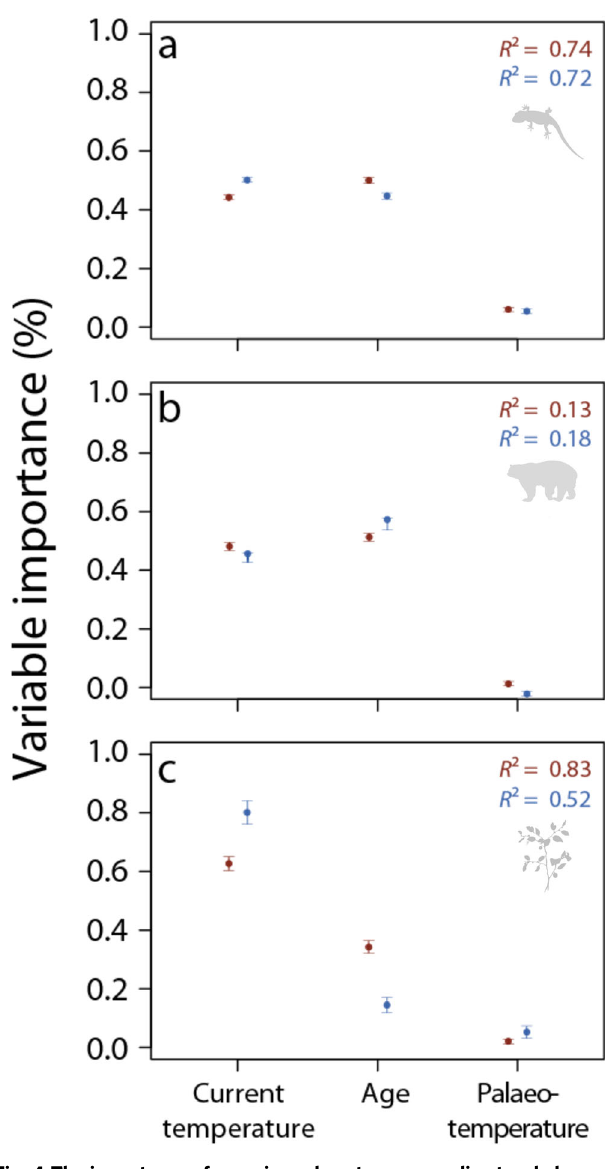
Fig. 4 The importance of experienced contemporary climate, clade evolutionary age and palaeoclimatic origin in predicting thermal limits. Variable importance in random forest models fi tting the relationships between upper (red) and lower (blue) thermal limits and predictors including palaeoclimatic origin (palaeo-temperature), experienced contemporary climate (current temperature) and clade evolutionary age (age) for a ectotherms, b endotherms, c plants (combing data from aquatic and terrestrial realms). Average model accuracy ( R ²) is reported for each model subset. Error bars represent 95% con fi dence intervals. For source data and sample sizes see Supplementary Table 5 and Supplementary Note